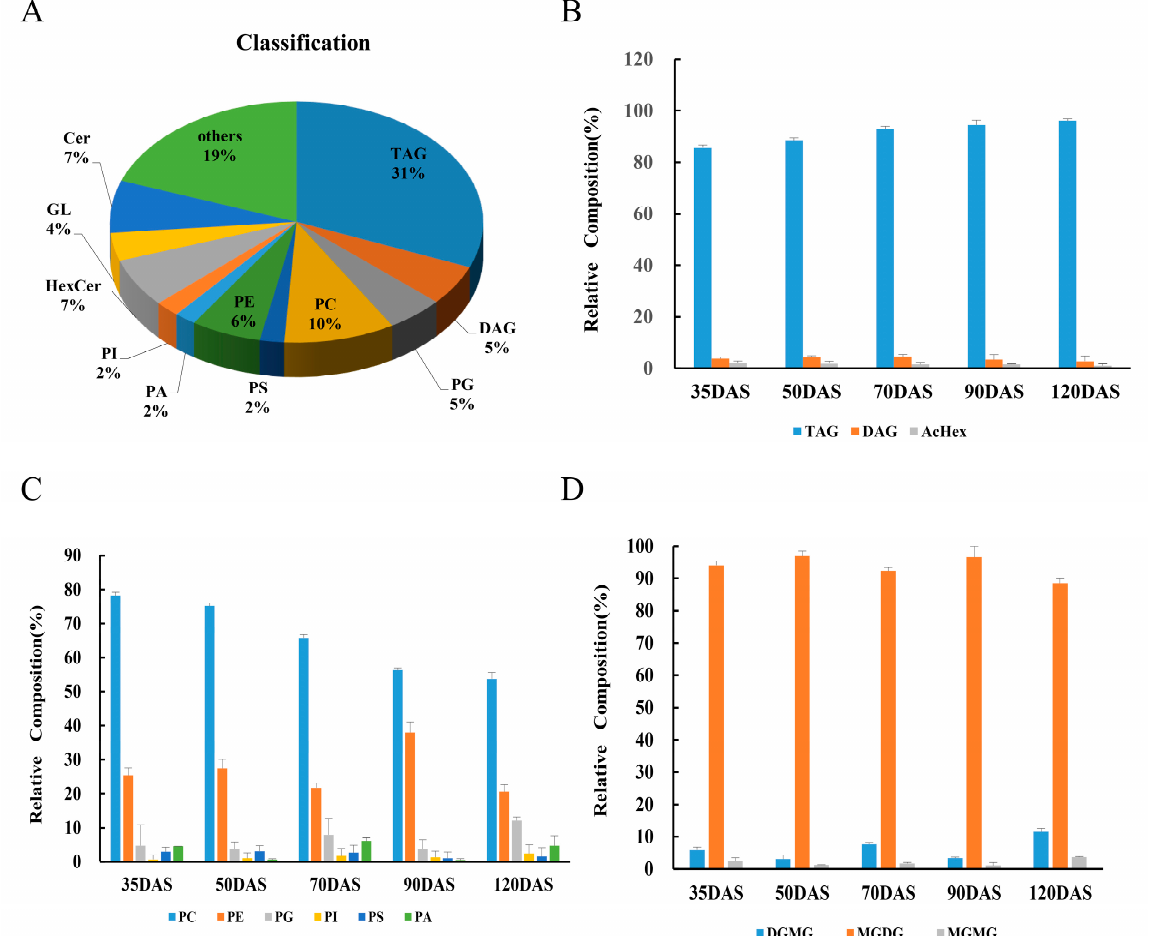
Figure 2. Lipids classification and composition during tuber development. ( A ) Lipids classification and composition; (B ). Relative proportion of Triacylglycerol composition. ( C ). Relative proportion of phospholipid composition. ( D ). Relative proportion of glycolipids composition. Five individual biological samples are demonstrated, each of which was analyzed with technical six duplicates (means ± SD). Five developmental stages were analyzed.